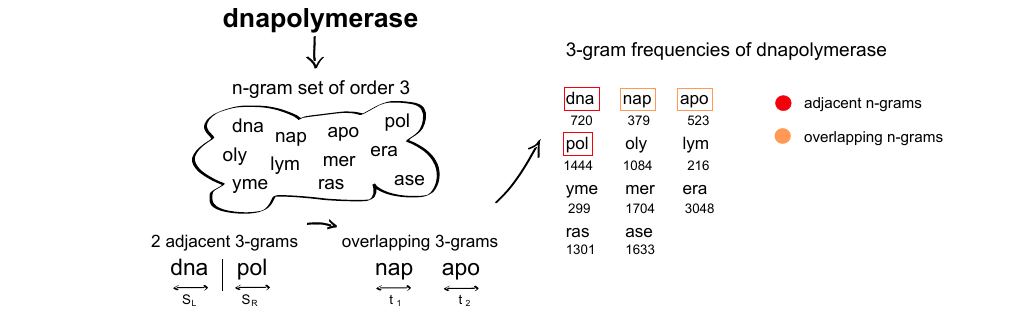
Figure 3: Illustration of the TANGO algorithm for word